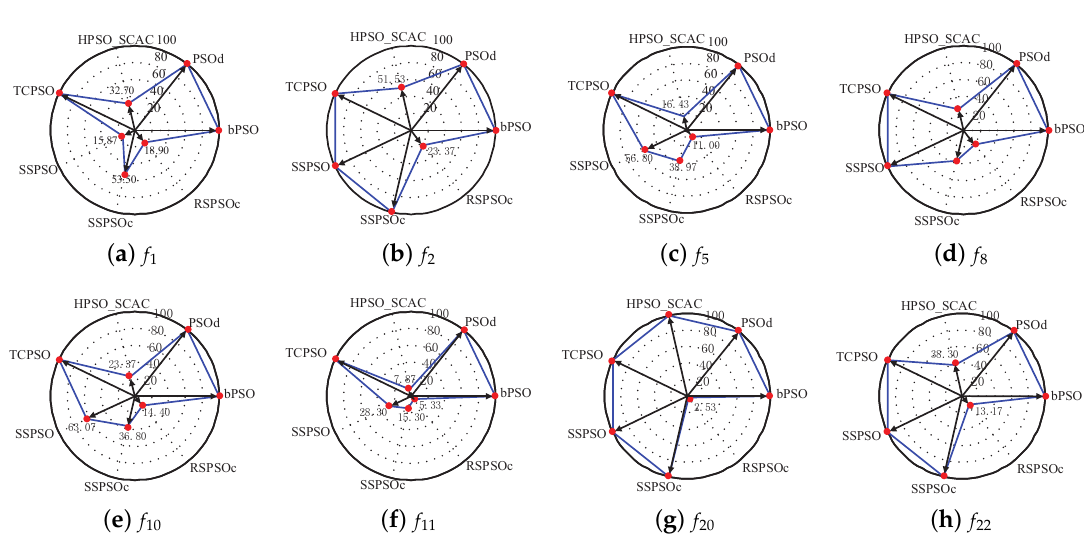
Figure 7. Radar charts of average iteration